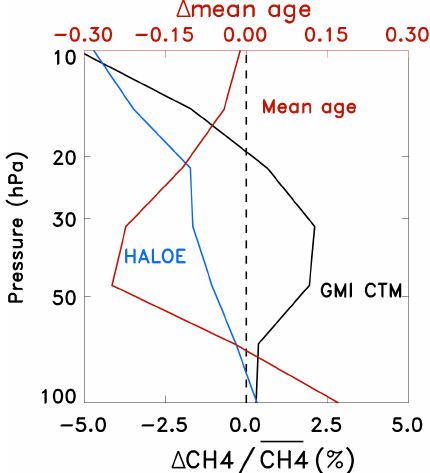
Figure 10. Percentage differences between 1994–1999 and 2000– 2005 winter mean CH 4 profiles at 35–55 ◦ N for HALOE (blue) and GMI CTM (black). The difference between the 35–55 ◦ N winter mean age profiles for the same periods is shown in